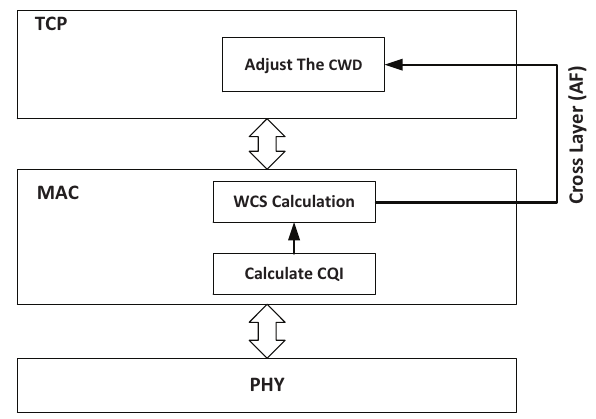
Figure 1. The Proposed scheme framework